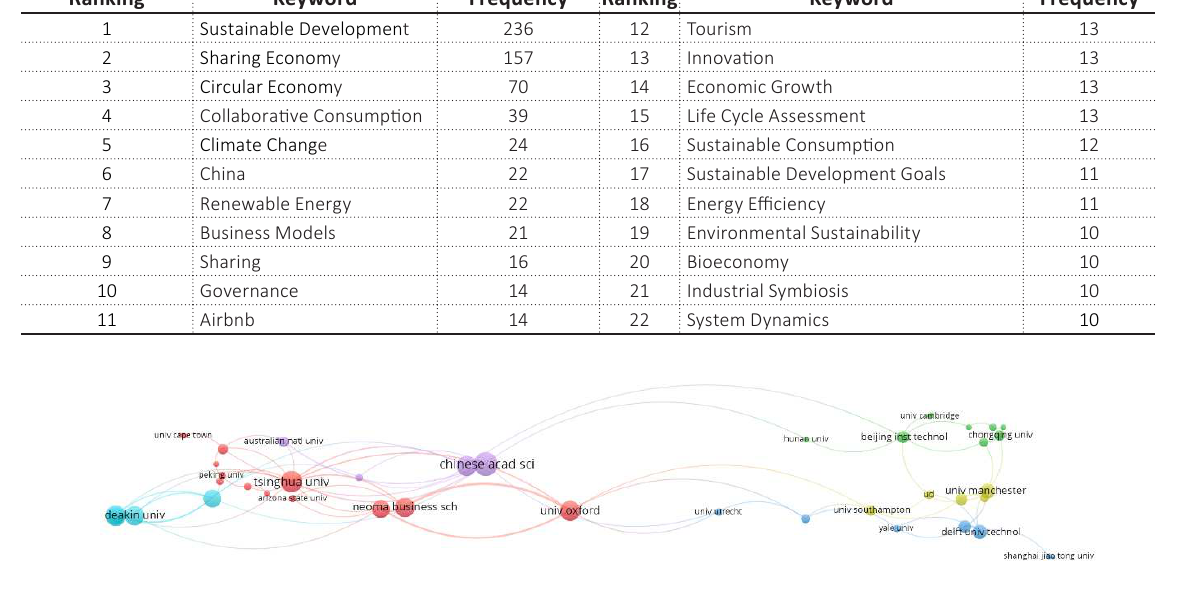
Figure 6. Cluster map of organizations researching this field from 2010 to 2020